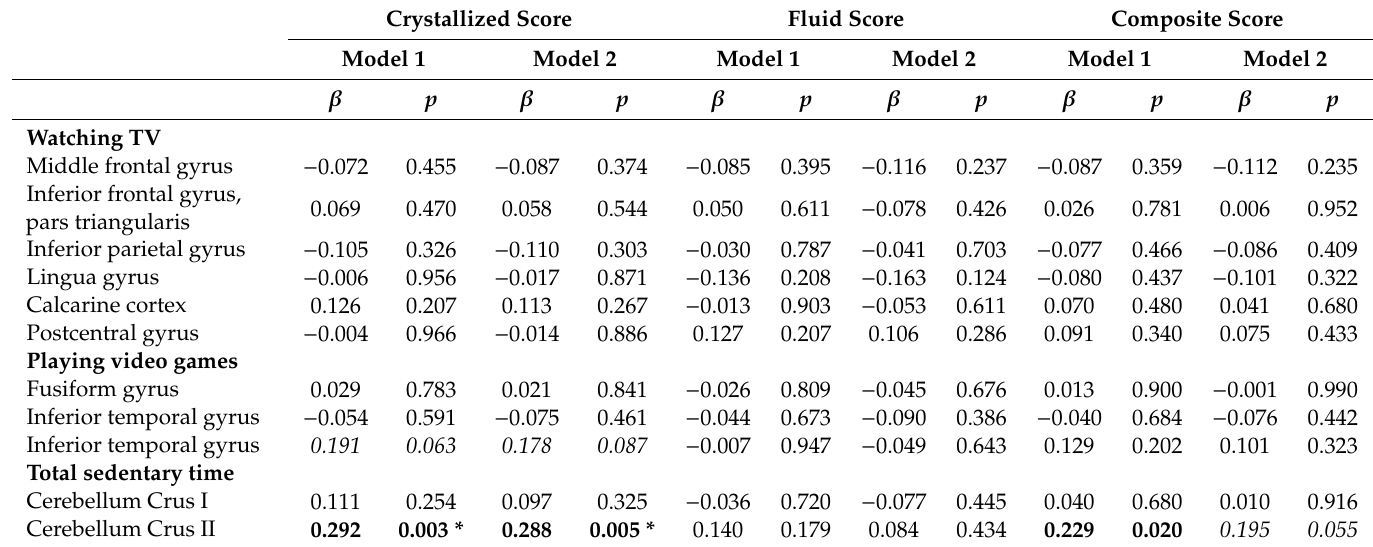
Table 3. Associations of sedentary behavior-related associations in gray matter with intelligence